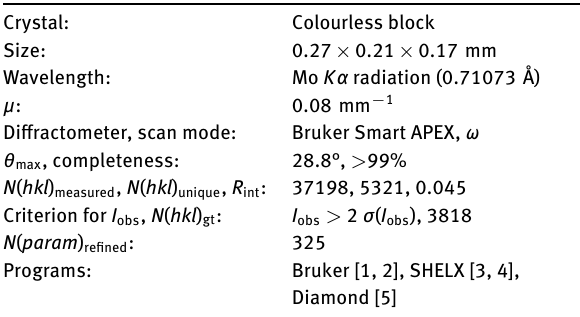
Table 1: Data collection and handling.